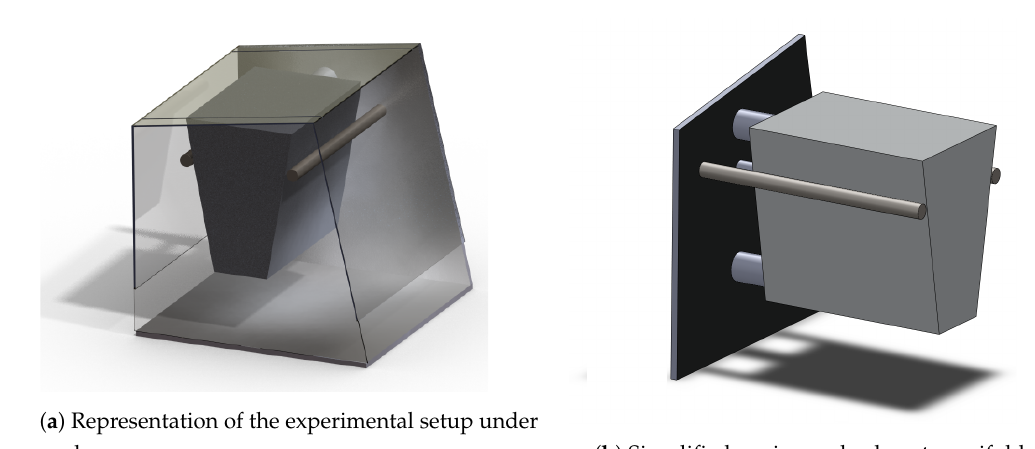
Figure 1. Experimental setup [10].